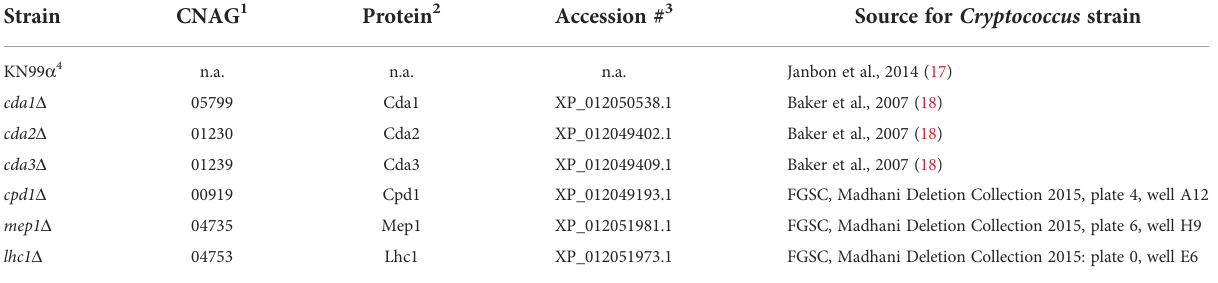
TABLE 1 C. neoformans strains